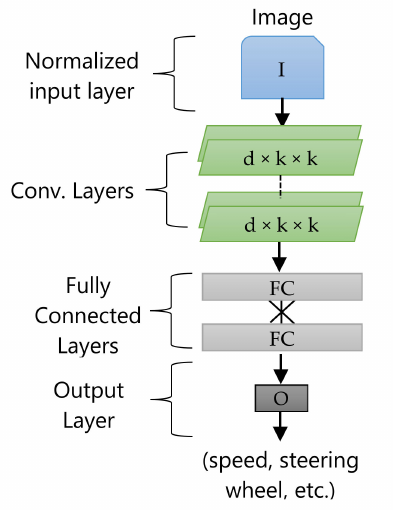
Figure 4. Single data e2e architecture